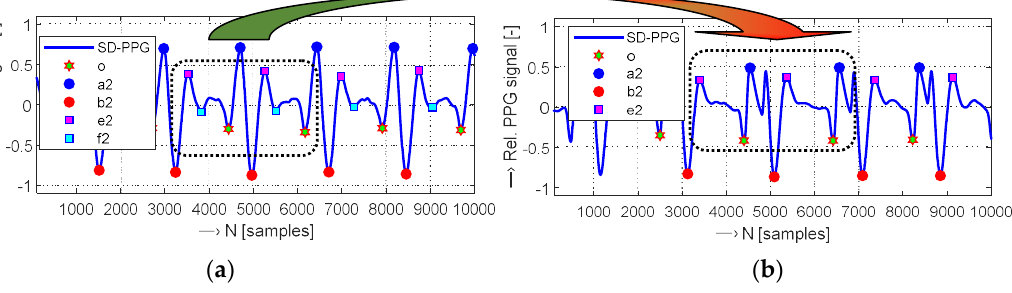
Figure 5. Comparison of two different SD-PPG signals: ( a ) PPG wave with presenting f 2 holes; ( b ) PPG wave practically without f 2 holes—this signal must be omitted.